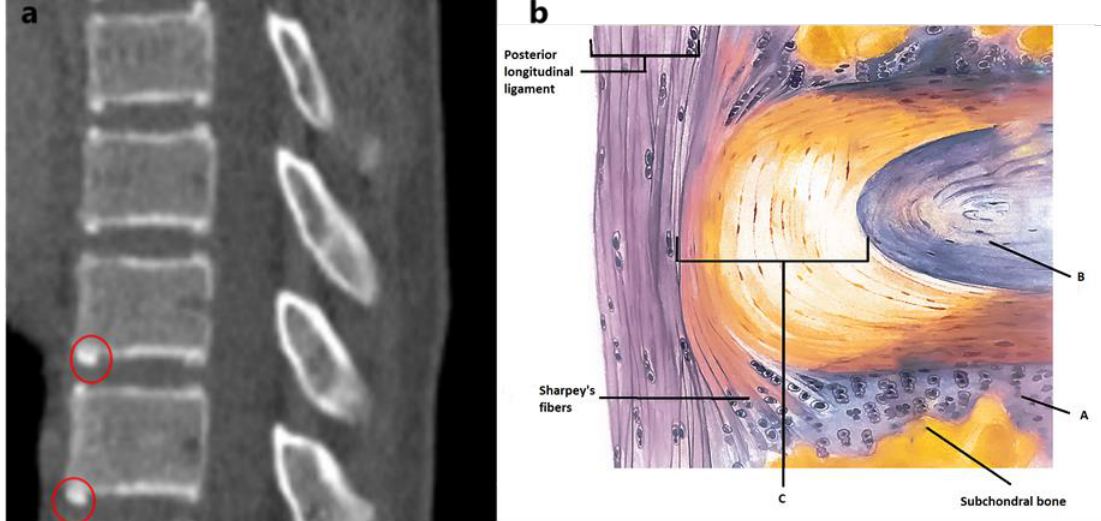
Figure 1. ( a ) A view of the ossified rings and the start of the fusion (red circles) to the vertebral body; ( b ) schematic anatomical view of the IVD and the attachment of the Sharpey’s fibers to cartilage tissue. A: cartilaginous endplate. B: Nucleus pulposus. C: Anulus fibrosus.